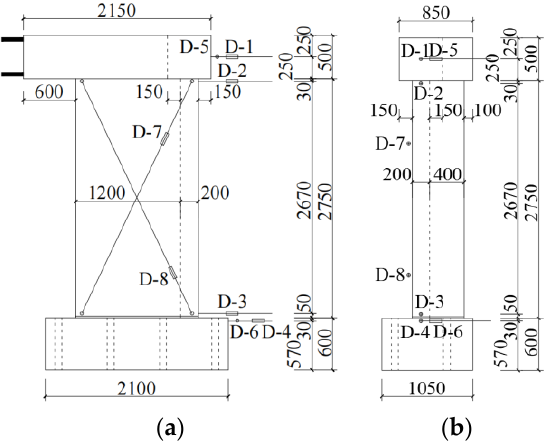
Figure 5. Dimensions of specimens and arrangement of displacement gauges: ( a ) front elevation of the specimen; and ( b ) side elevation of the specimen.